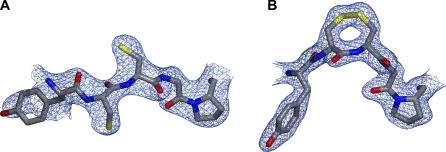
σA Weighted Electron Density Maps (2Fo-Fc) Contoured at 1σ in the Vicinity of Cys-370 and Cys-371(A) In the GDP-bound structure [16], Cys-370 and Cys-371 are reduced. (B) In the inhibitor-bound structure, the cysteine residues form a vicinal disulfide bond, causing the intervening peptide bind to take on a cis configuration. (Carbon is indicated by grey, nitrogen by blue, oxygen by red, and sulfur by yellow.)